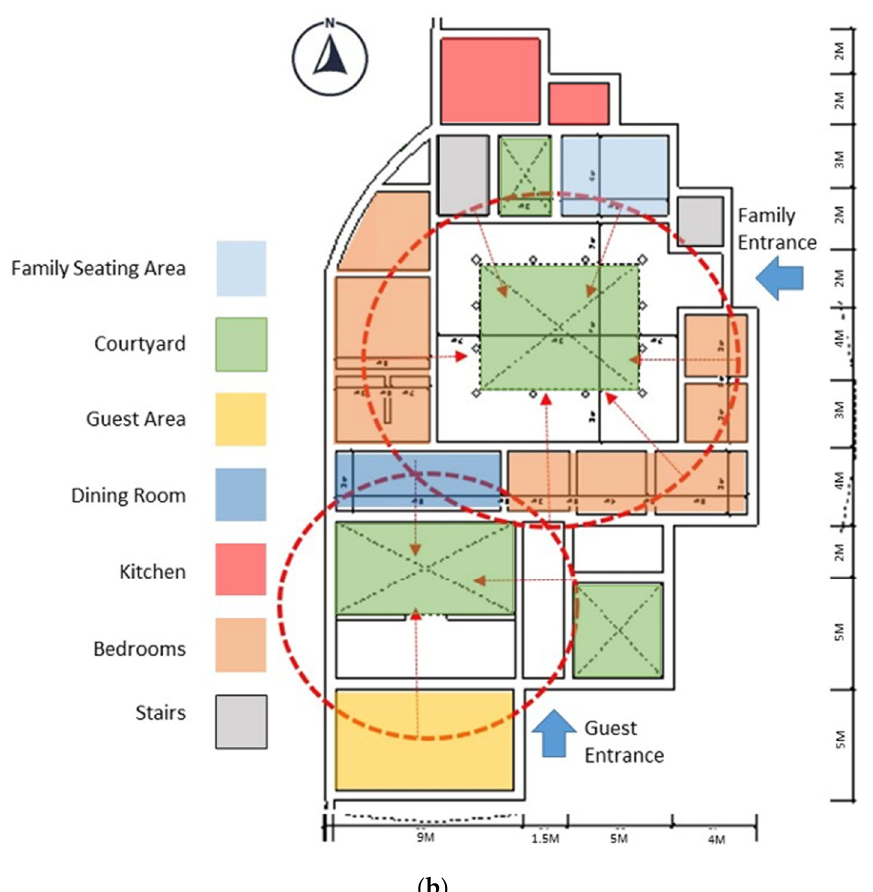
Figure 6: ( a ) the design concept for traditional house in Riyadh city, KSA; and ( b ) the design concept for traditional house in Hail city, KSA.